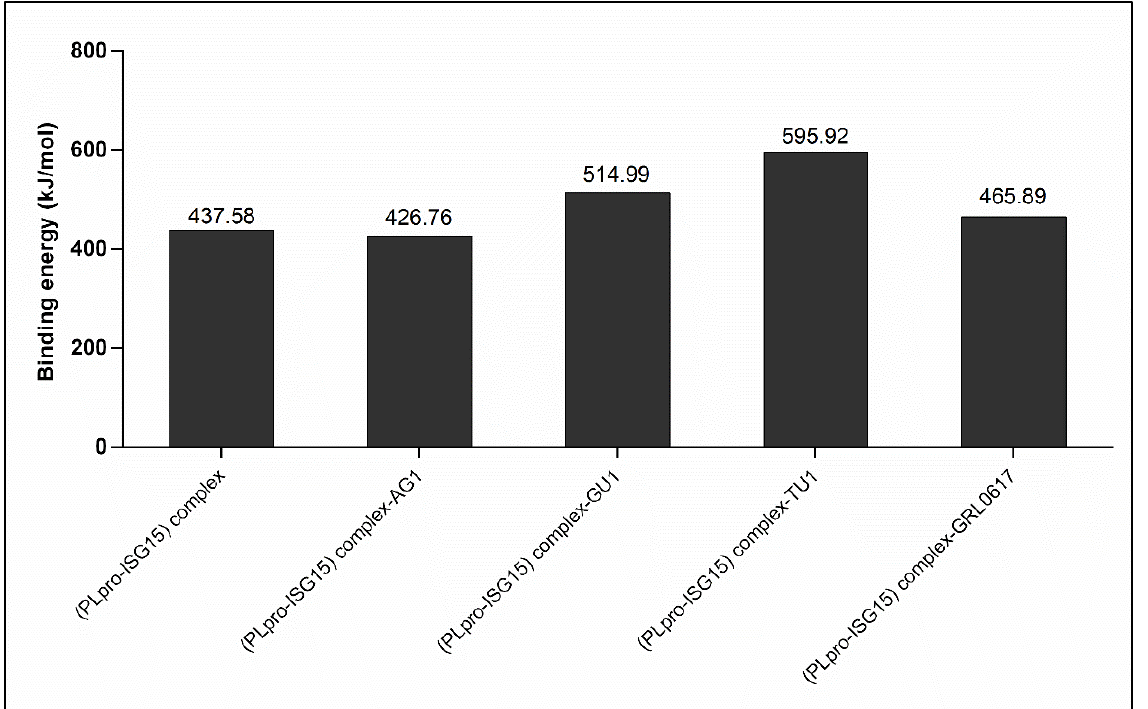
Figure 7. Protein–protein MMPBSA value (kJ/mol) for PLpro-ISG15 complex, PLpro-ISG15 complex with AG1, PLpro-ISG15 complex with GU1, PLpro-ISG15 complex with TU1 and PLpro-ISG15 complex with GRL0617.